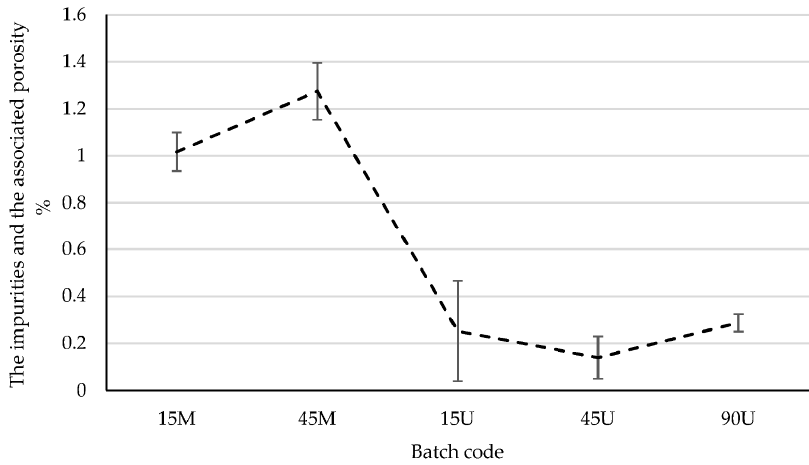
Figure 7. The content of impurities and the associated surface porosity for all batches.